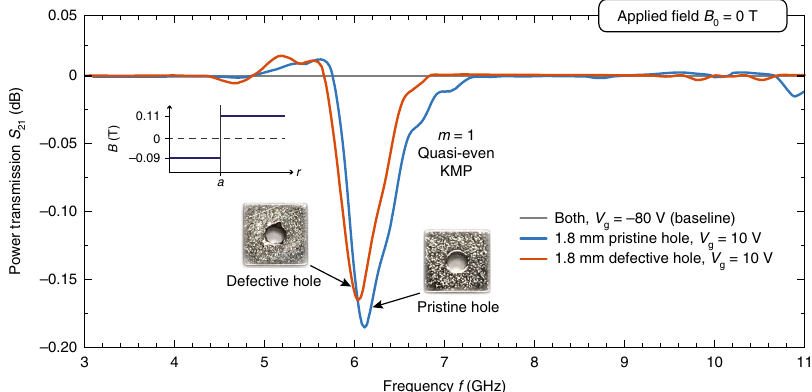
¼ 10 for each signal and (cid:3) 80 V for each baseline. b Comparison g